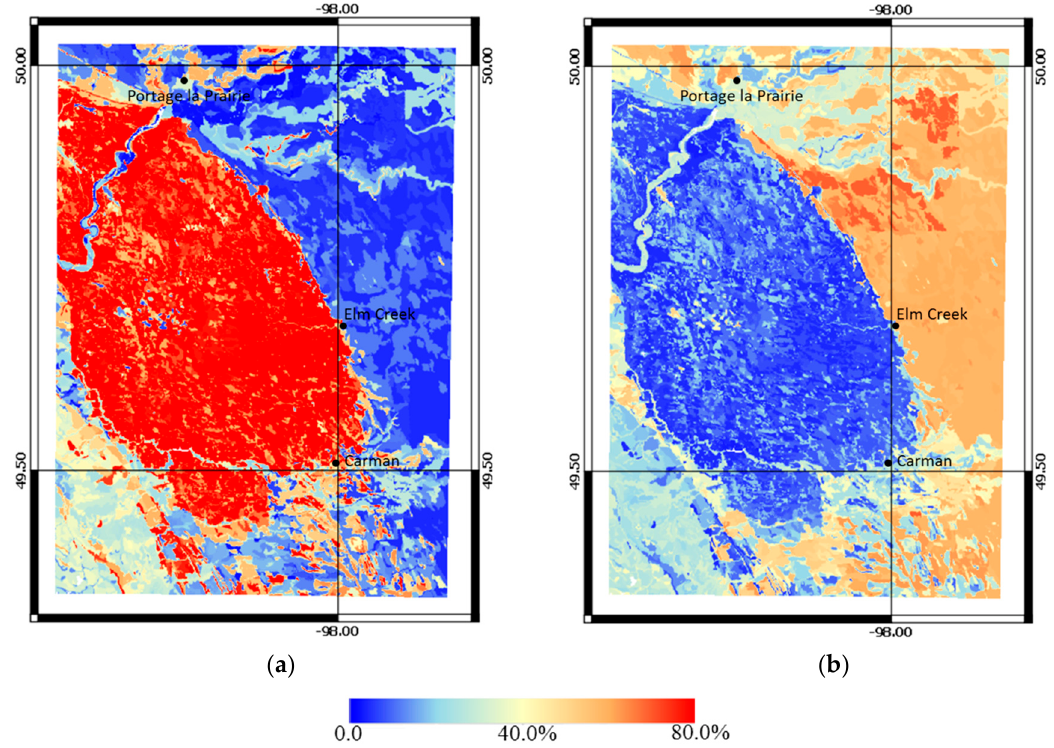
Figure 3. Percentage of ( a ) sand and ( b ) clay in the test site.